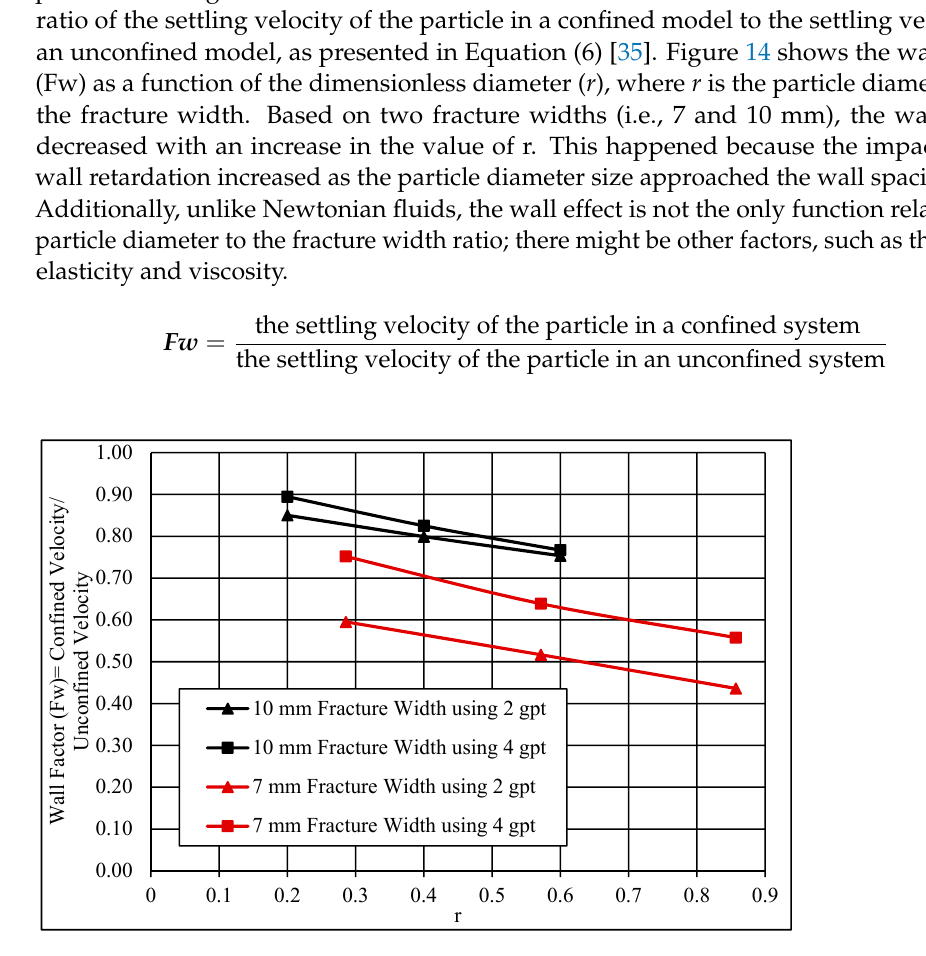
Figure 14. Wall effect using two fracture widths and two friction reducer concentrations.